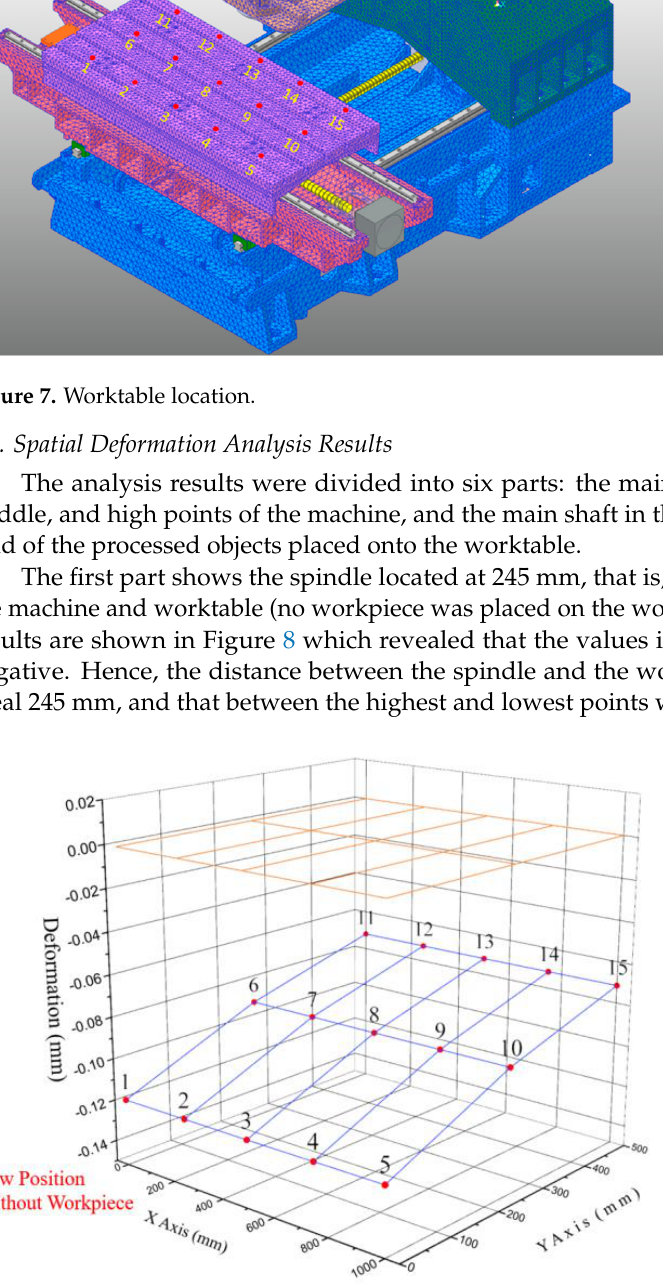
Figure 8. Schematic diagram of no load at the low point of the spindle.